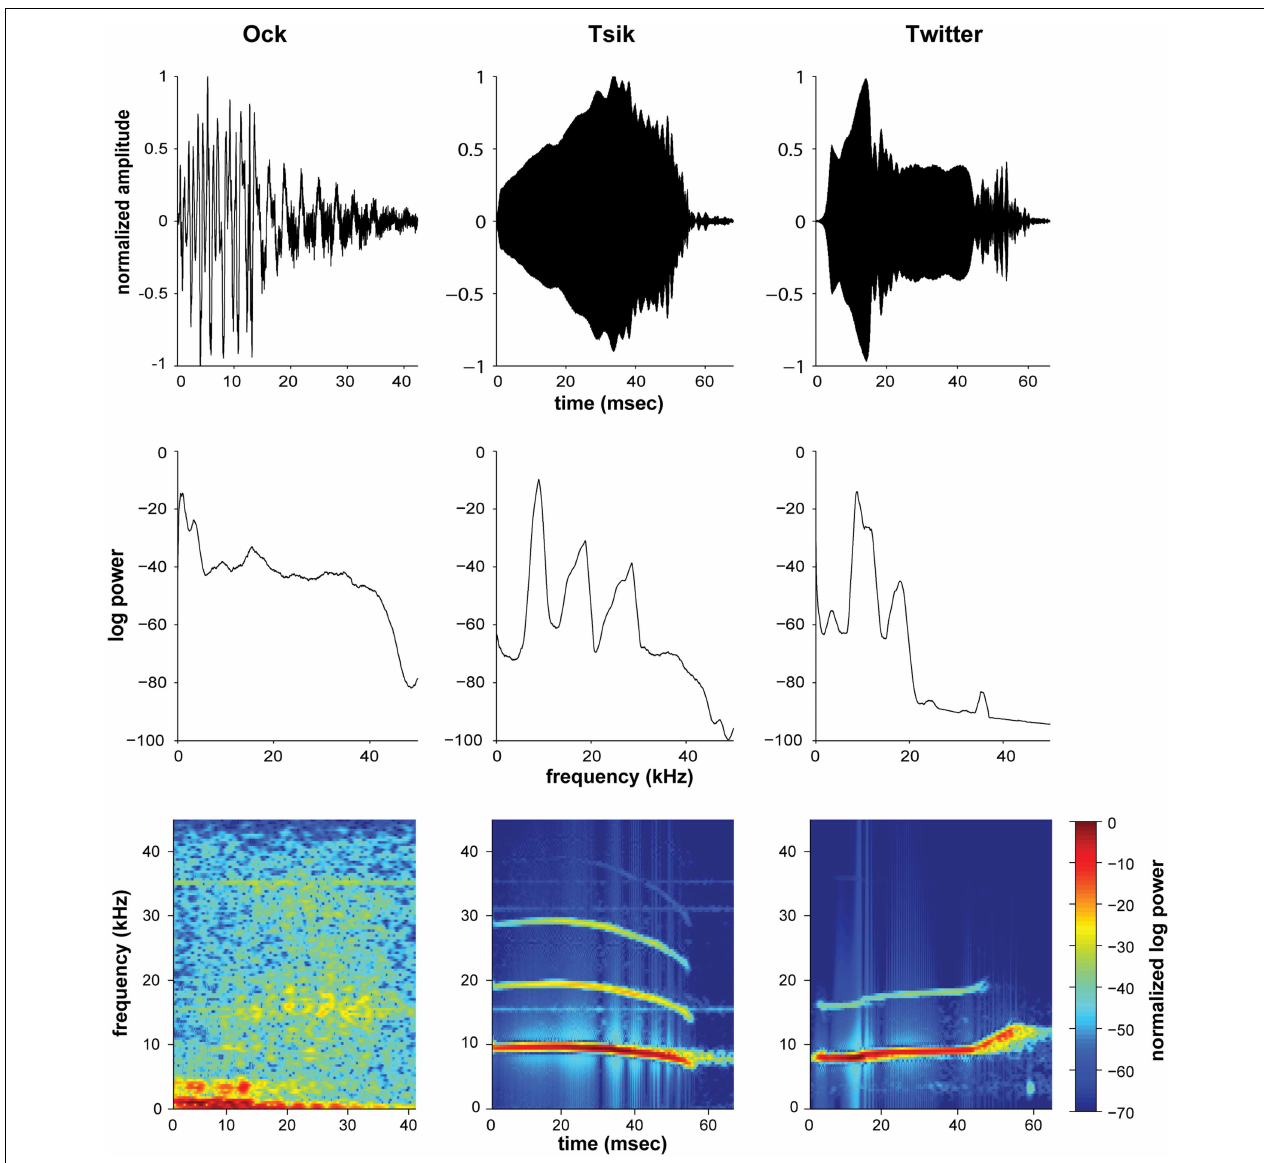
FIGURE 1 | Waveforms (top), Fourier transforms (middle) and spectrograms (bottom) of the three natural stimuli used in this study, the Ock (left), Tsik (center) and the first syllable of Twitter (right). The Fourier transforms and spectrograms were computed using